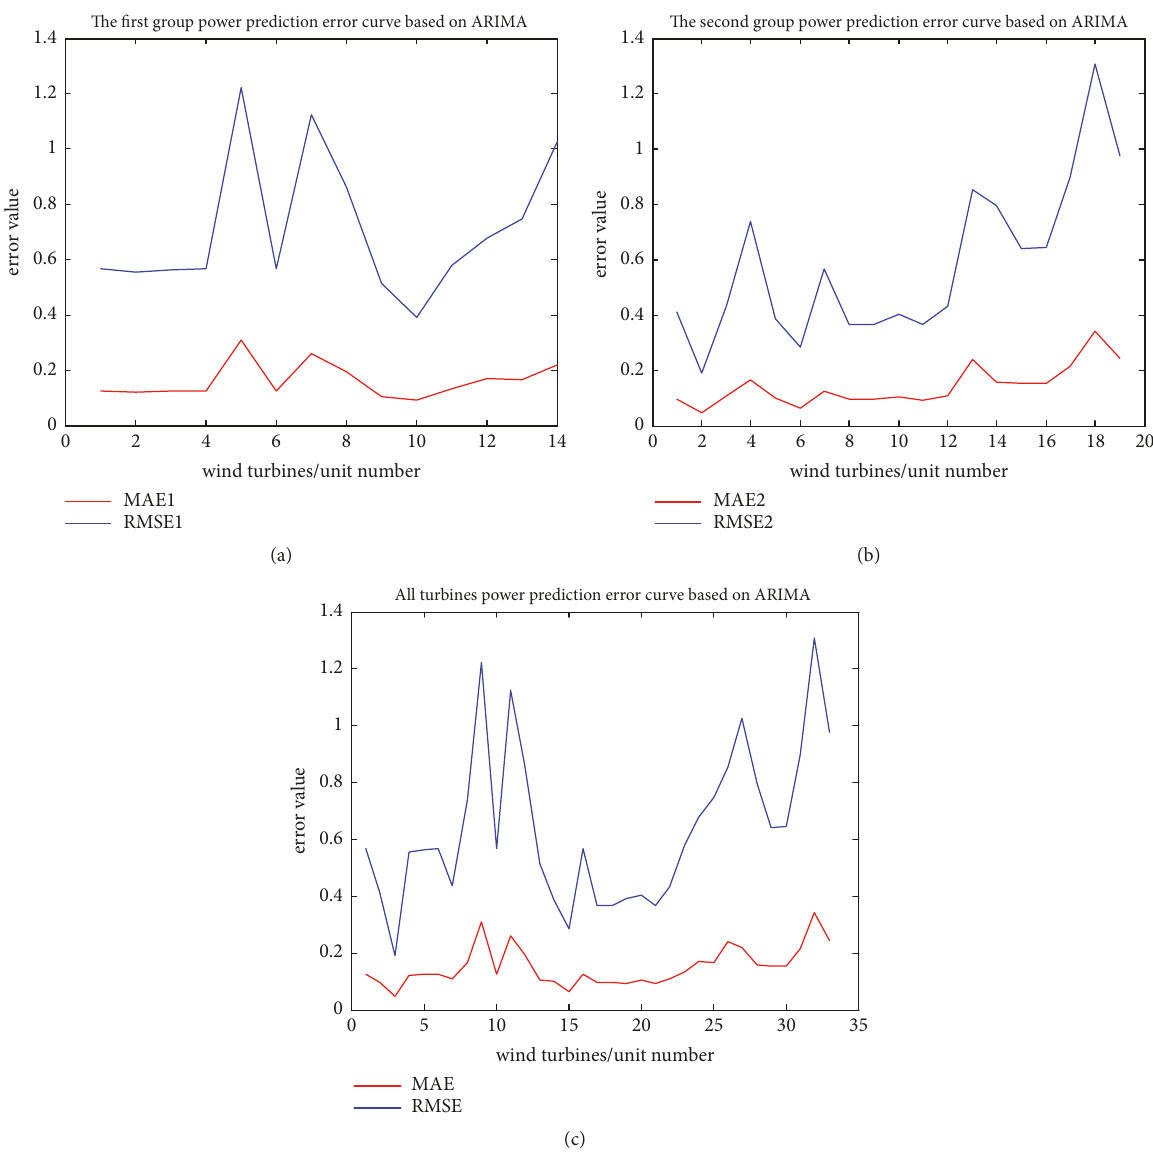
Figure 9: Wind power forecast error curves based on ARIMA